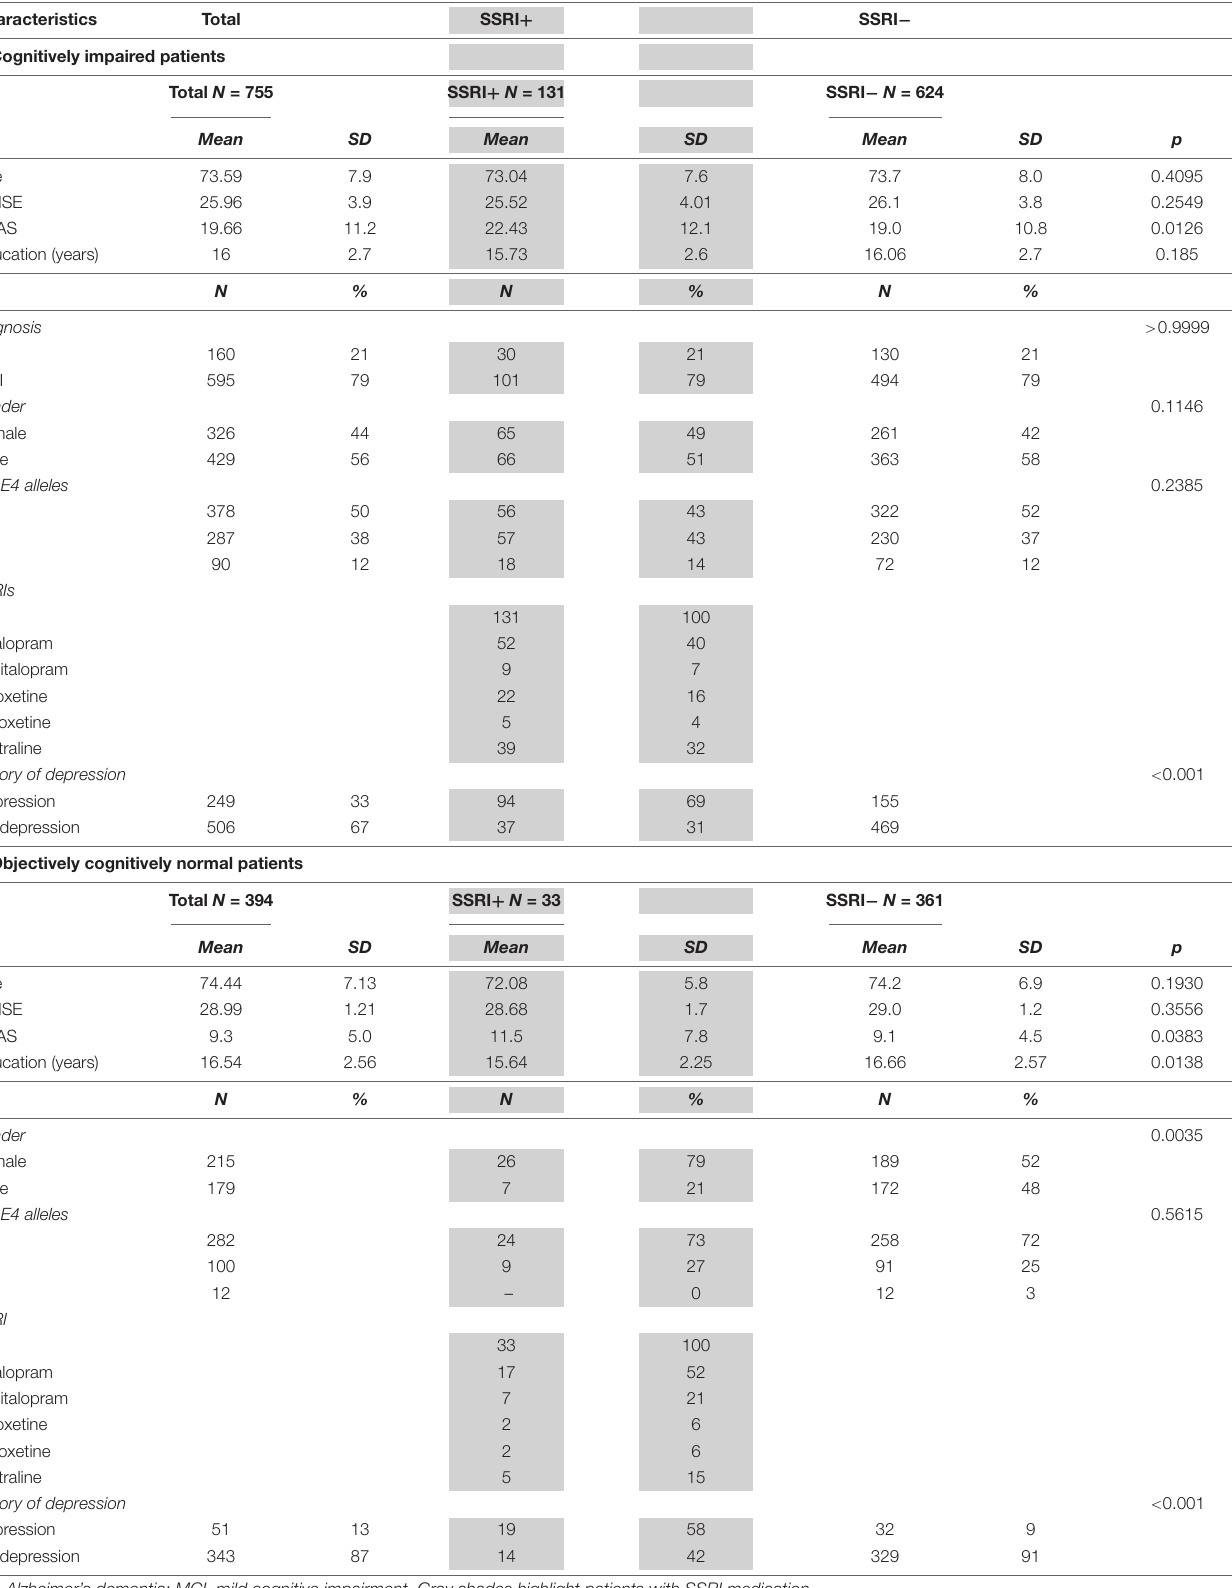
TABLE 2 | Patient